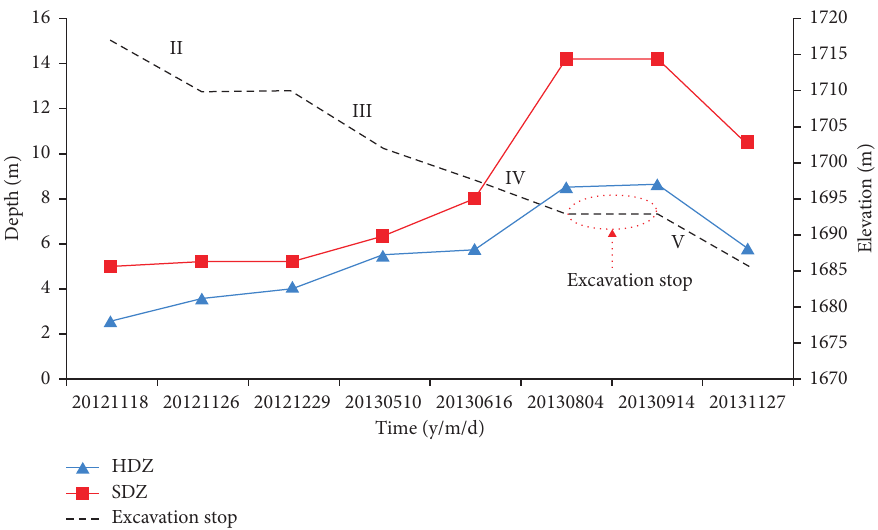
Figure 17: A typical process of EDZs evolution in section of 0+008.8m in the main powerhouse of Houziyan